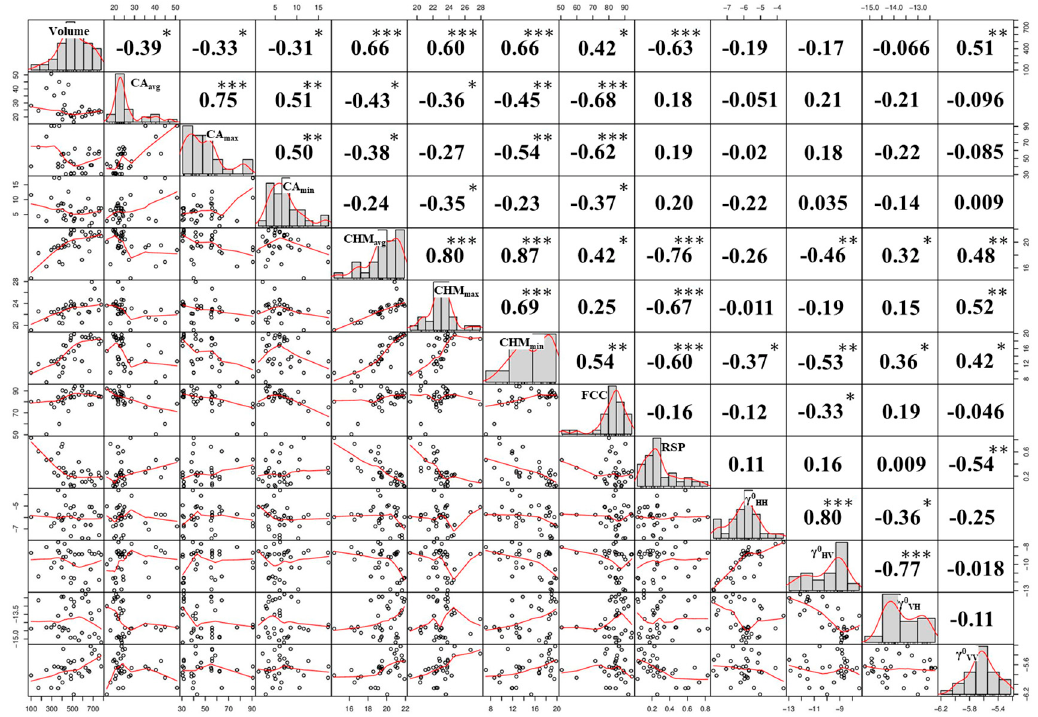
Figure 8. Correlation matrix with significant levels between stem volume and other 12 variables. Diagonal matrices show the histogram of the data distribution. The left half is the bivariate scatter plot with fitted line. The right half shows the Pearson correlation and the significance level associated with a symbol: p -values < 0.001 (***), < 0.01 (**), < 0.05 (*).